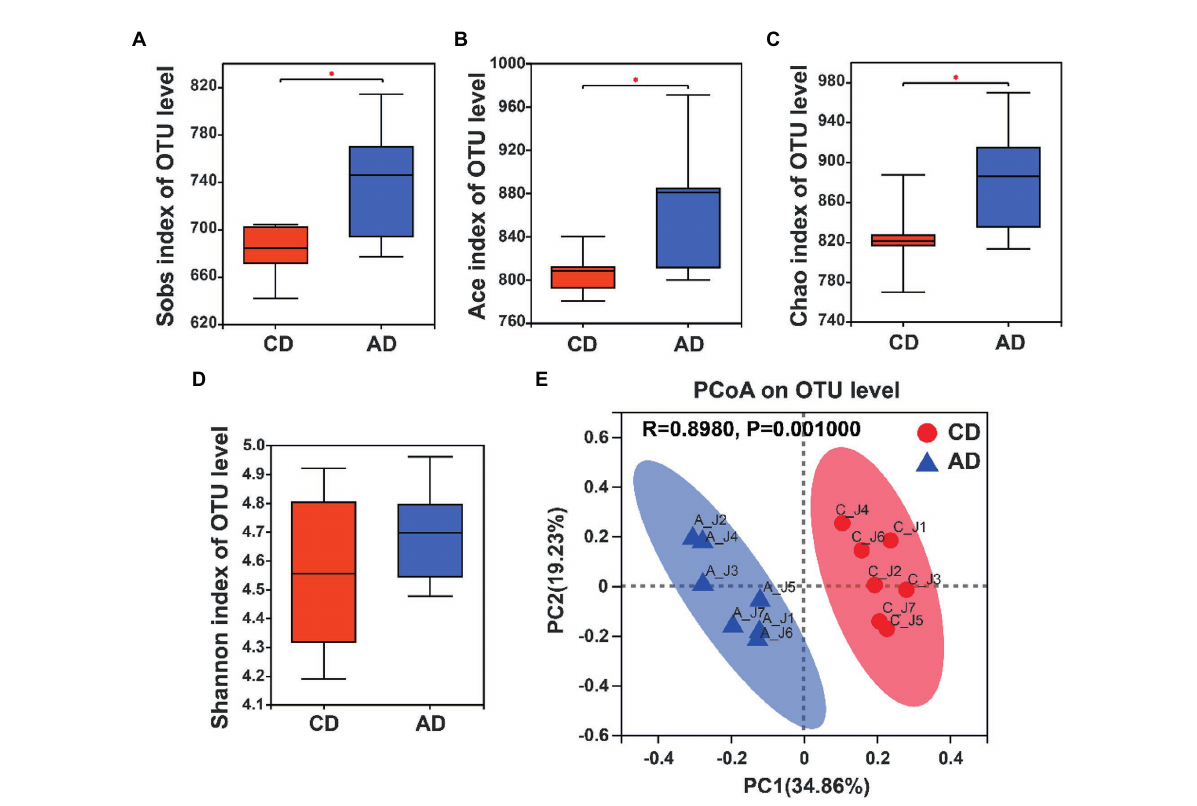
FIGURE 3 Alpha-diversity analysis and beta-diversity of microbiota composition in colonic samples among CD and AD groups. (A) Sobs index, (B) Ace index, (C) Chao index, (D) Shannon index. (E) PCoA analysis based on Bray–Curtis distance matrix with ANOSIM test. *Indicates p < 0.05 between CD and AD group. CD, control diet; AD, alfalfa